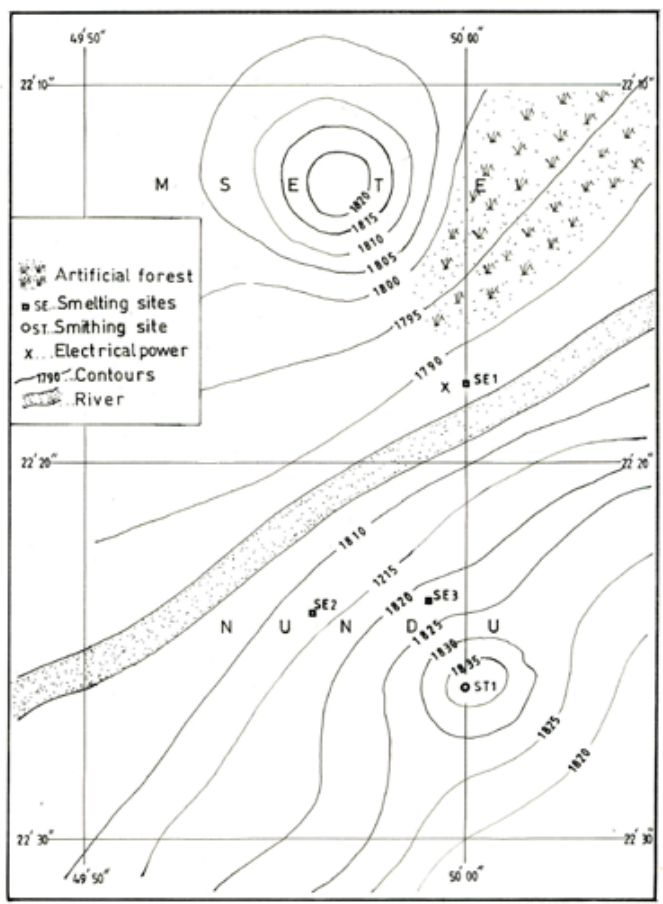
Fig 2: The Mjimwema sites